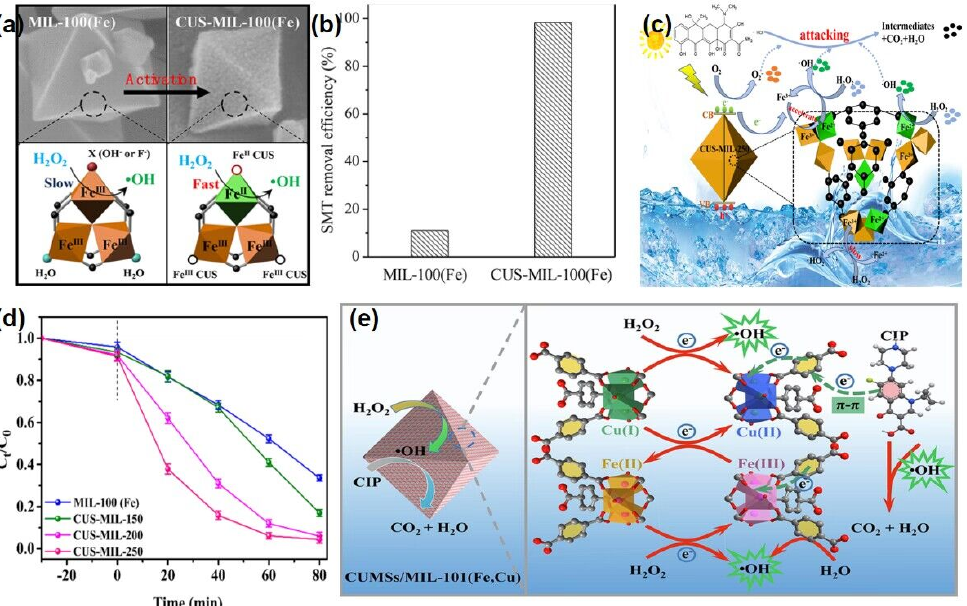
Figure 9. ( a ) Schematic illustration of the H 2 O 2 activation by CUS − MIL − 100(Fe) [54]; ( b ) The SMT removal efficiency by MIL − 100(Fe) and CUS − MIL − 100(Fe) [54]; ( c ) Schematic illustration of reaction mechanism in CUS − MIL − 250/H 2 O 2 /Vis reaction system [55]; ( d ) Degradation of TC–HCl [55]; and ( e ) Mechanism for CIP removal [56].